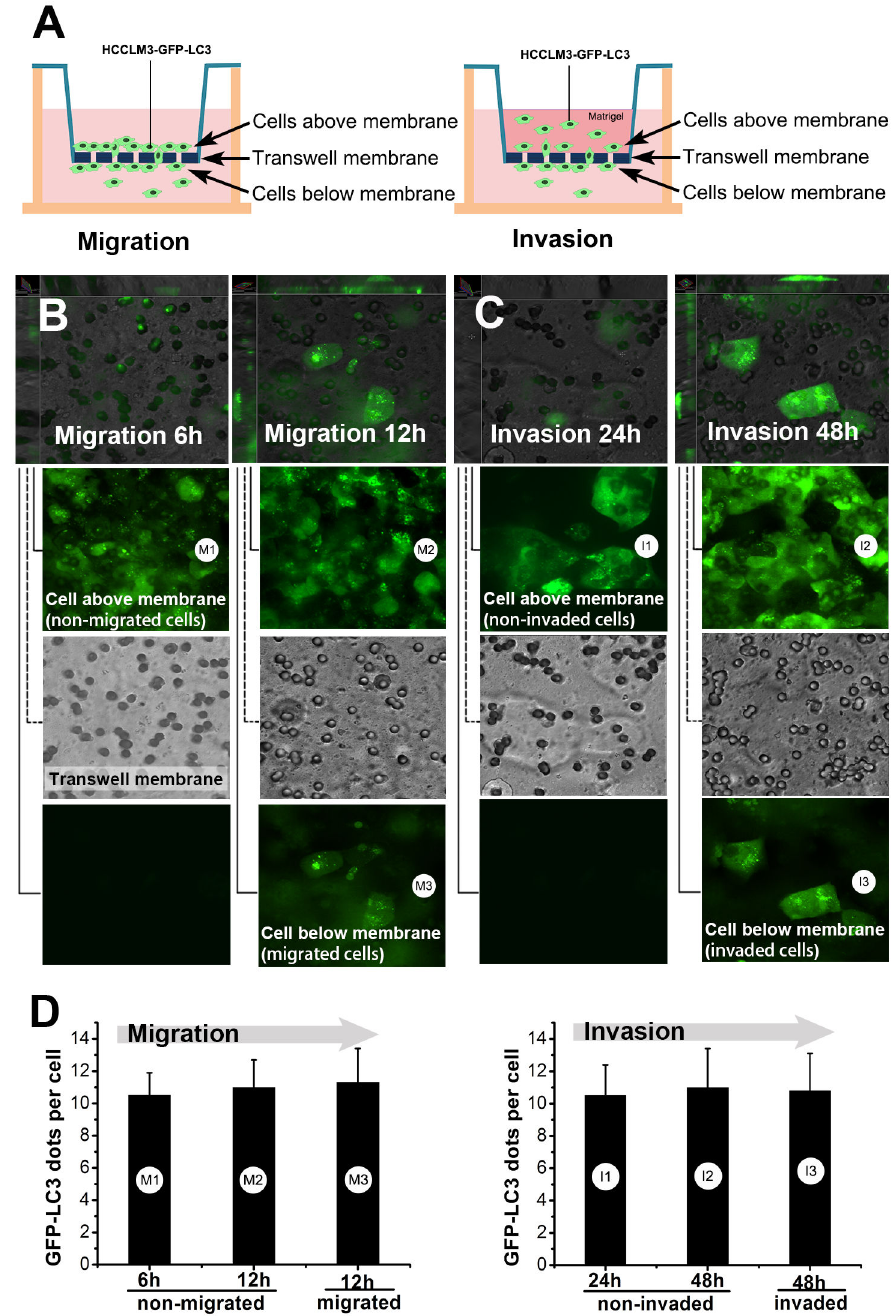
Figure 5. Dynamic monitoring of autophagy showed no significant changes of autophagic activity during cell migration and invasion. (A) In vitro migration and invasion models were established using stable GFP-LC3-expressing HCC cells (HCCLM3- GFP-LC3) and transwell system. (B, C) Confocal microscopic monitoring of HCCLM3-GFP-LC3 cells as they migrated through the transwell membrane or invaded through the matrigel and transwell membrane. The HCCLM3-GFP-LC3 cells migrated or invaded through transwell membrane after 6 hours and 24 hours, respectively. The images were displayed in stacked XYZ-planes mode and separated Z-plane mode. Cells above transwell membrane were non-migrated / non-invaded cells (M1, M2 / I1, I2) while cells below transwell membrane were migrated / invaded cells (M3 / I3). (D) Autophagy was quantified by counting the number of GFP-LC3 dots per cell. The numbers of GFP-LC3 dots per cell in migrated / invaded cells were not significantly different from those in non- migrated / non-invaded cells (M3 vs . M2, M2 vs . M1, M3 vs . M1, I3 vs . I2, I2 vs . I1, I3 vs . I1, all P >0.05).